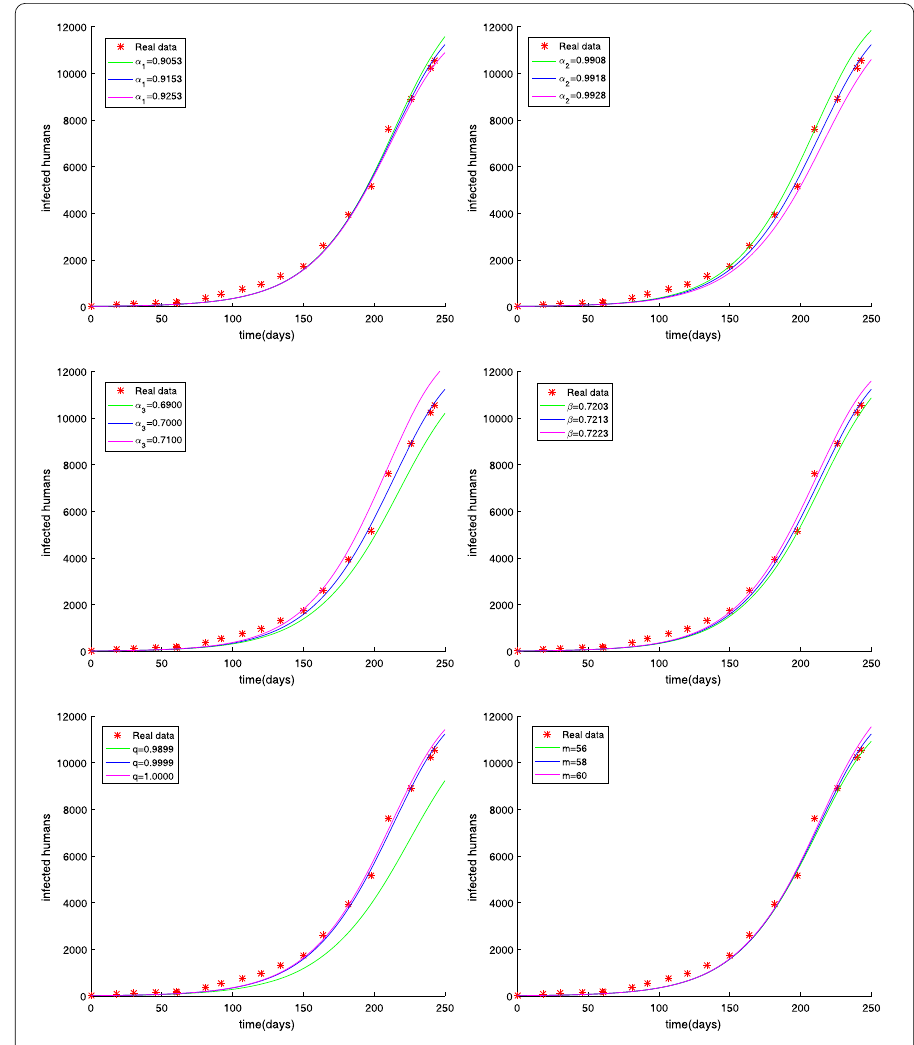
Figure 7 The influence of α 1 , α 2 , α 3 , β , q , m on the number of Ebola infections I ( t ), when the remaining parameters are